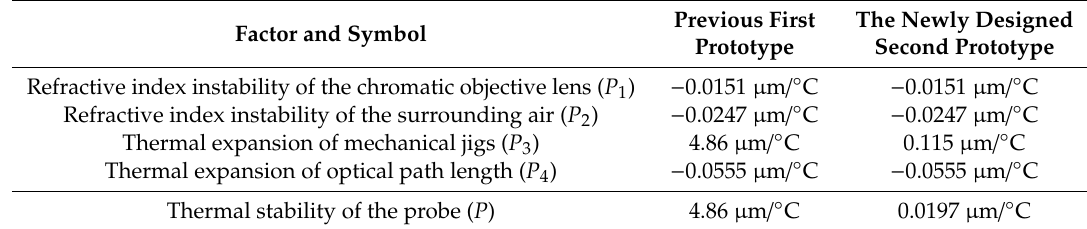
Table 4. Theoretically estimated thermal stabilities of the previous first prototype probe and the newly designed second prototype probe.